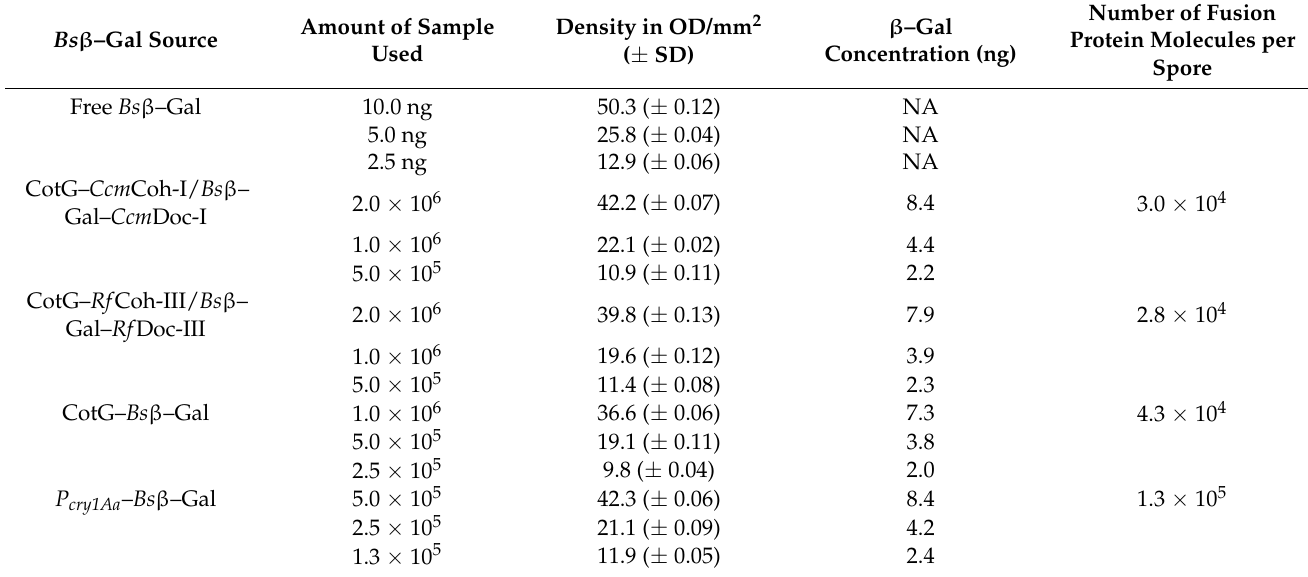
Table 1. Quantification of Bs β –Gal expression by dot-blot analysis. Amount of Sample Density in OD/mm 2 Used ( ± SD)